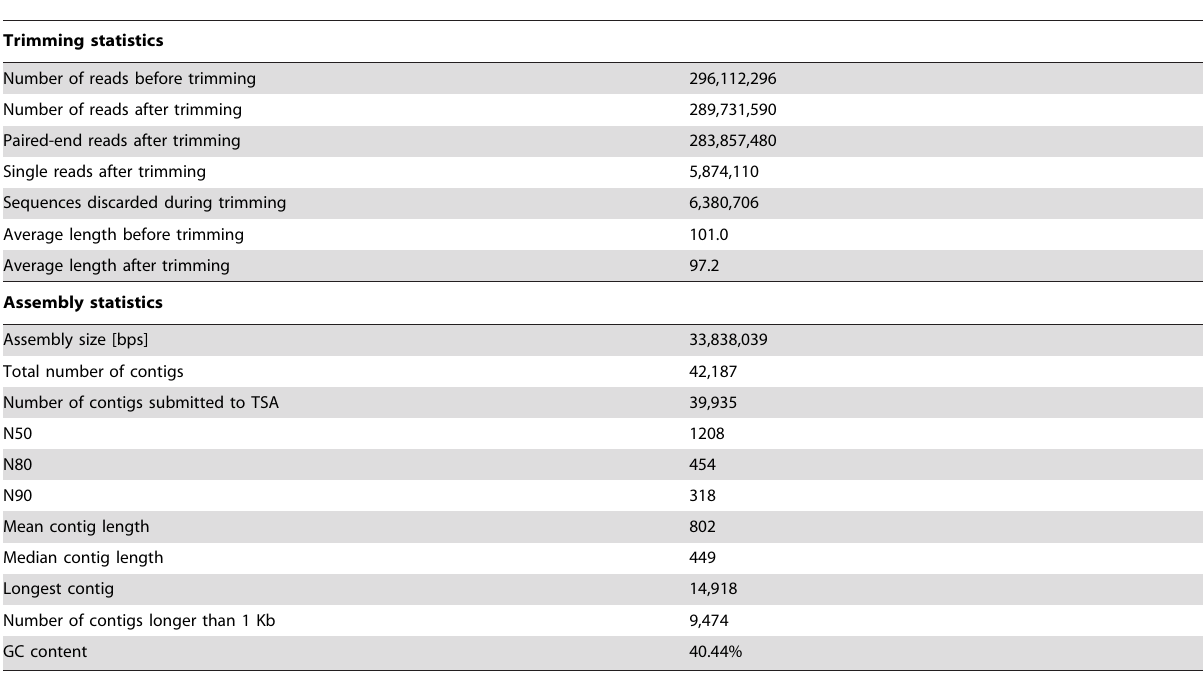
Table 2. Trimming statistics and assembly summary of the Reference dataset.